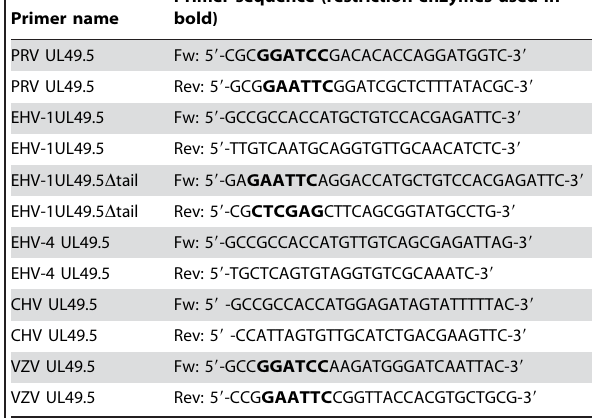
Primer sequence (restriction enzymes used in